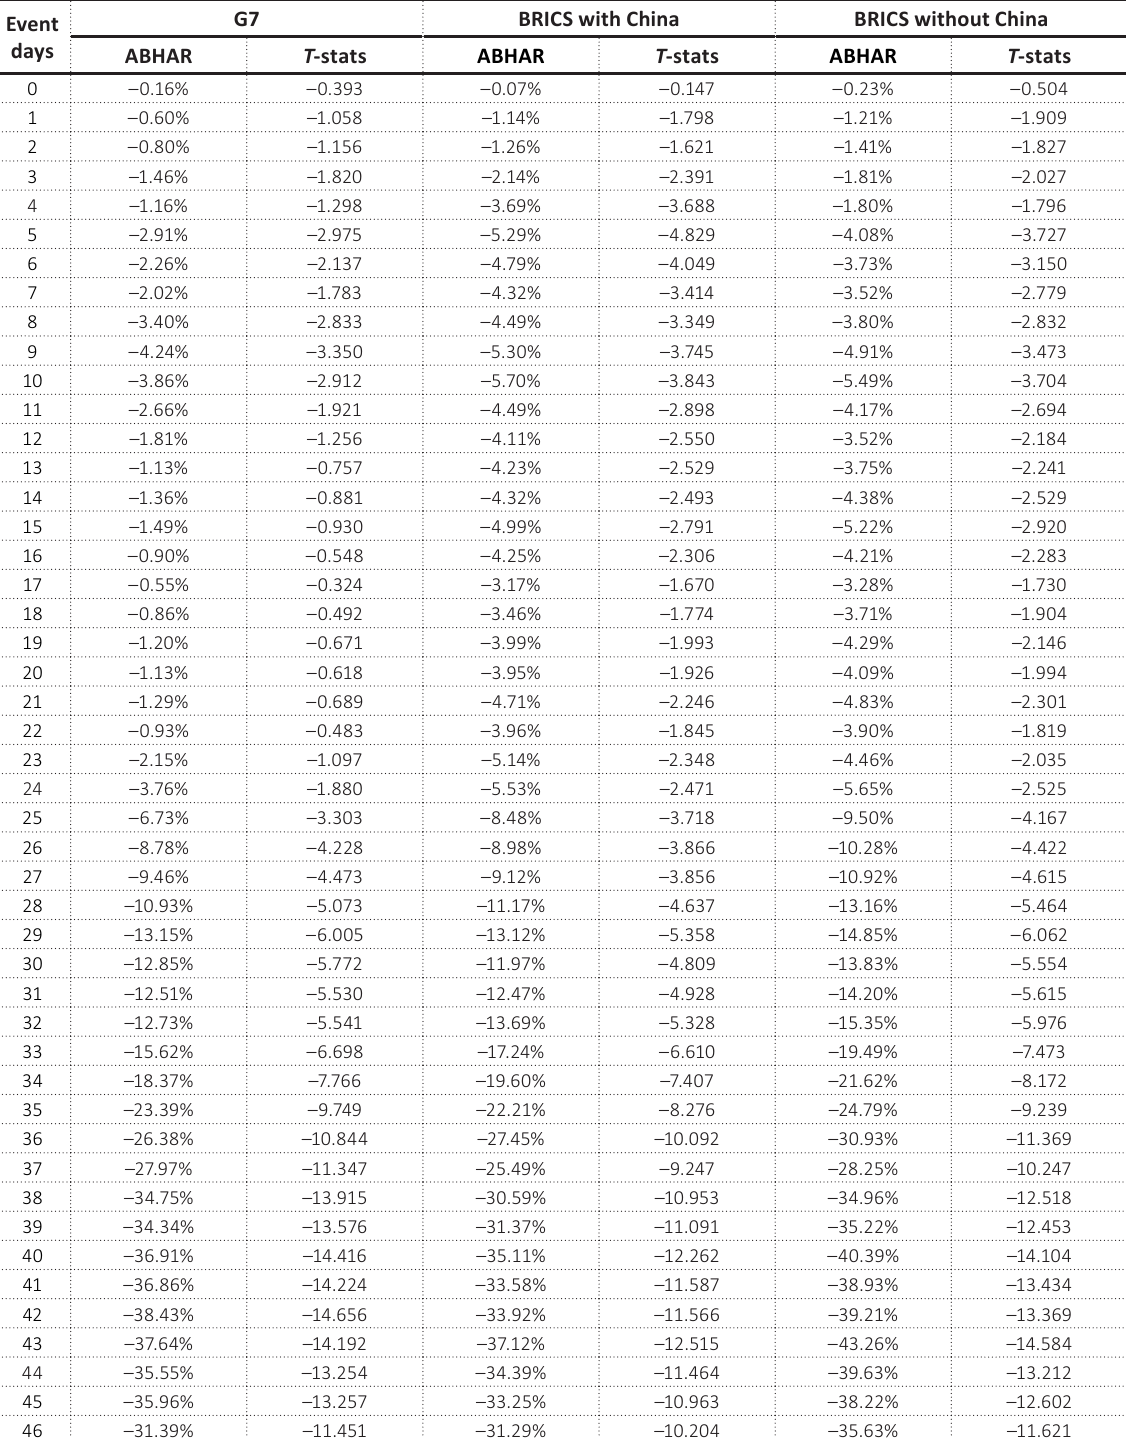
Table A1. ABHAR values with t-Stats for G-7 and BRICS except for China for a 90-day